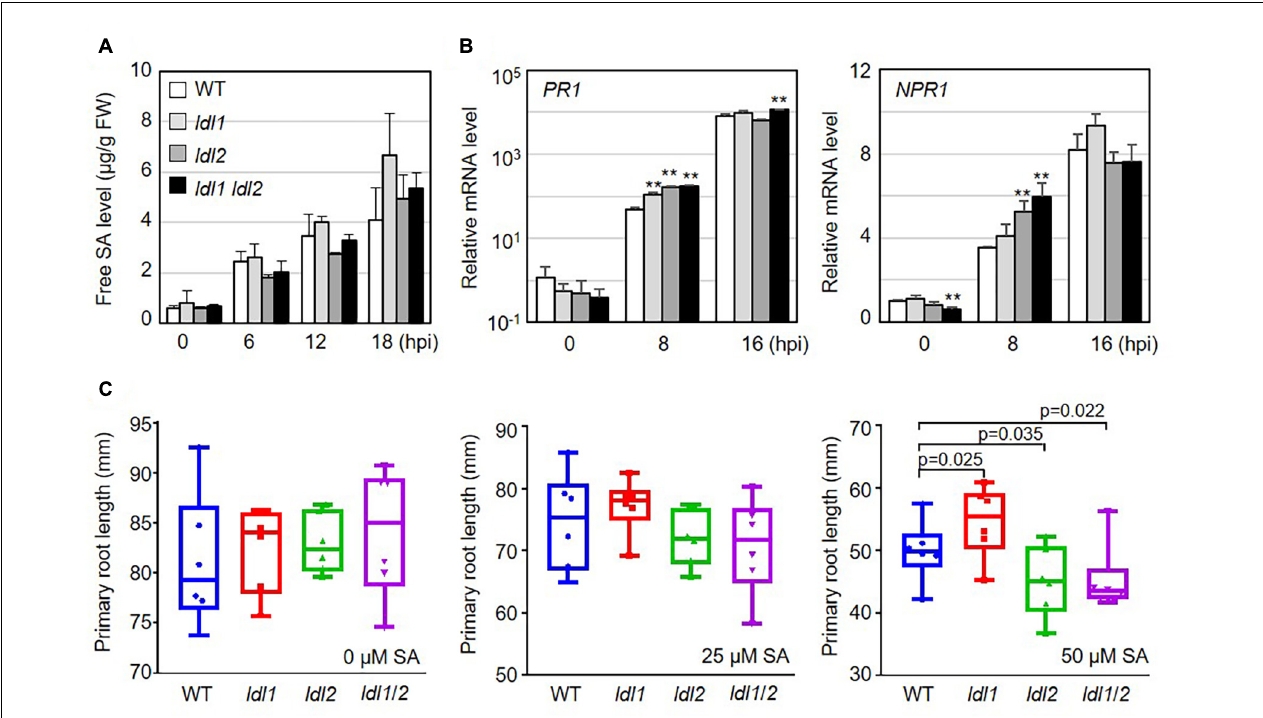
FIGURE 2 | Transcription of salicylic acid (SA)-dependent signaling genes is more rapidly induced in ldl mutants than in WT plants after Pseudomonas infection. (A) Free SA levels in the leaves of Arabidopsis plants infected with the virulent Psm ES4326 strain (OD 600 = 0.01). The experiments were repeated three times with similar results. (B) Rapid expression of SA-responsive genes in Psm ES4326 (OD 600 = 0.01)-infected leaves of ldl1 , ldl2 , and ldl1 ldl2 plants. The averages ± SD (standard deviation) were plotted (** p < 0.01, two-tailed Student’s t -test, n = 3). Five biologically independent experiments with 3 technical repeats were performed, with similar trends, as shown in Supplementary Figure 2 . (C) Primary root growth of WT, ldl1 , ldl2 , and ldl1 ldl2 plants grown in half-strength MS medium supplemented with 25 and 50 µ M SA for 14 days. Box plots show the minimum, first quartile, median, third quartile, and maximum values. Each dot represents the average of independent biological replicates ( n = 6), with fives samples per individual replicate ( p -Values from two-tailed Student’s t -test, n =